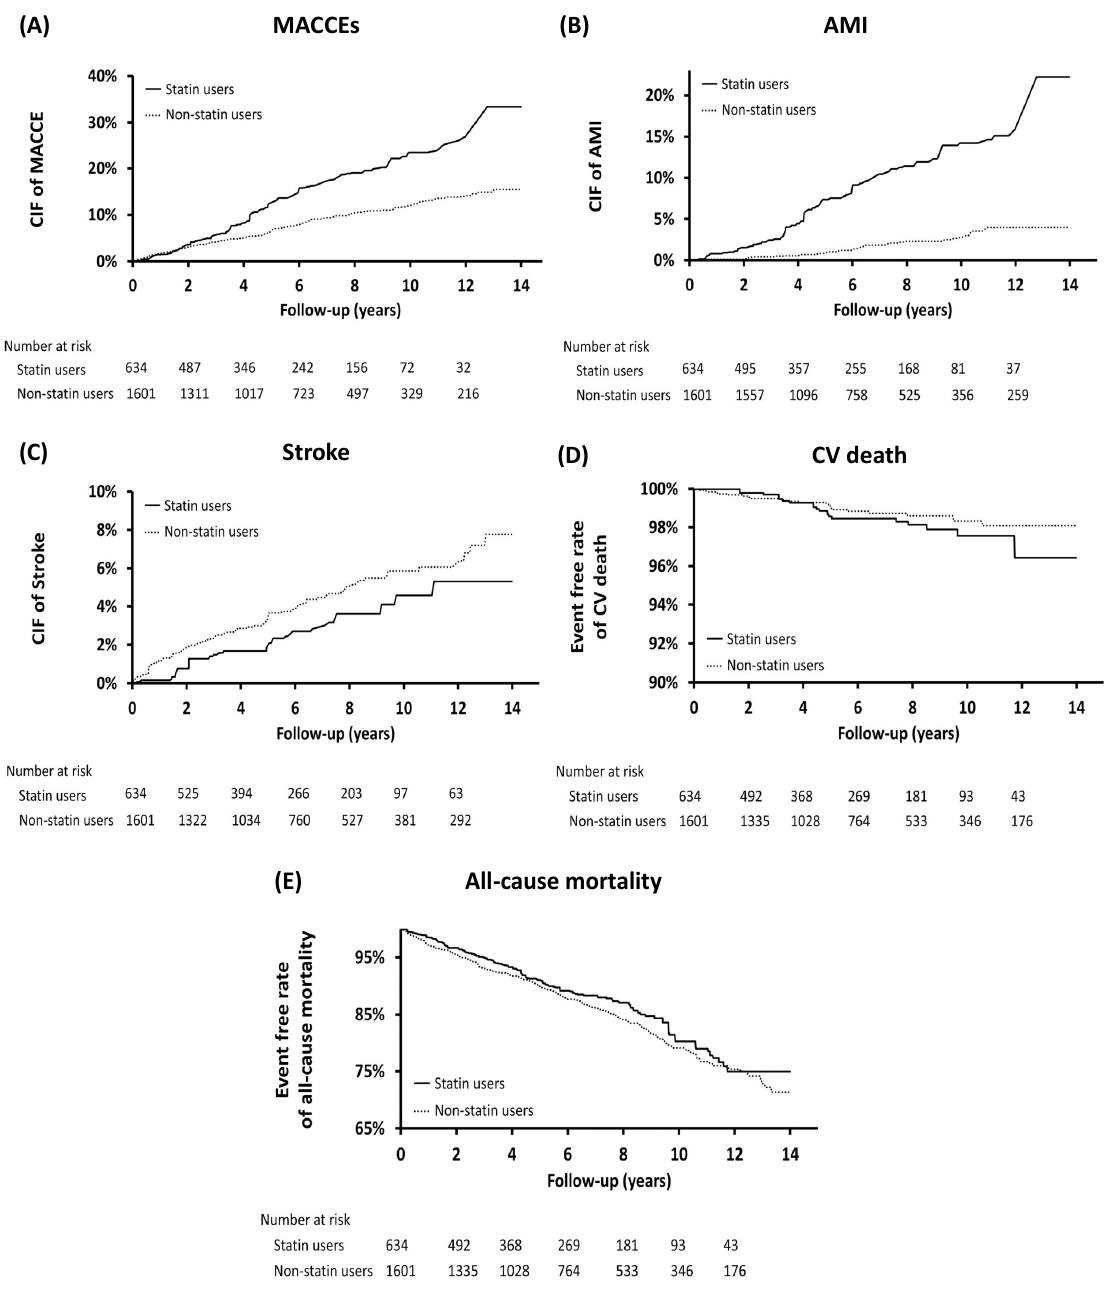
Figure 2. Cumulative incidence of ( A ) major cardiac and cerebrovascular events (MACCEs), ( B ) acute myocardial infarc- tion [30], ( C ) stroke, ( D ) cardiovascular (CV) death, and ( E ) all-cause mortality. CIF: cumulative incidence function.